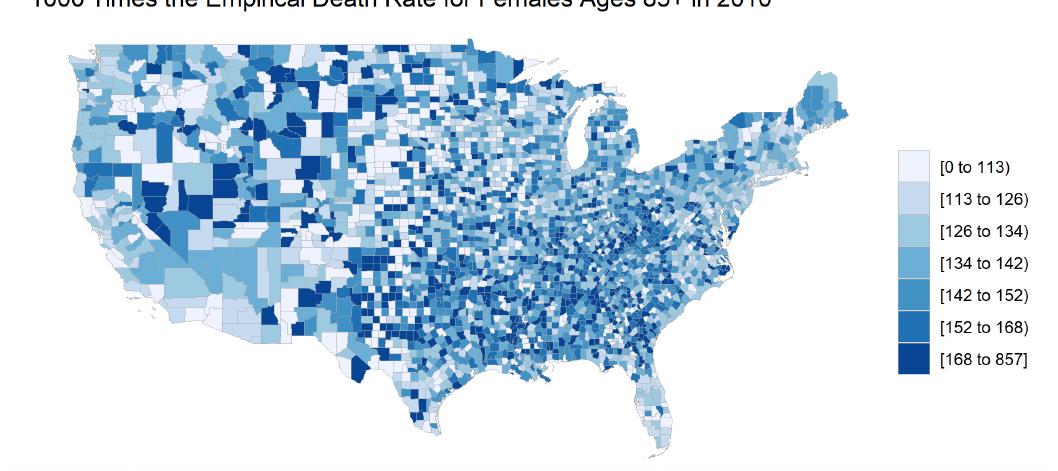
Figure 2. The county-level empirical mortality rates for females ages 85 and older in 2010. The mortality rates are multiplied by 1000 for